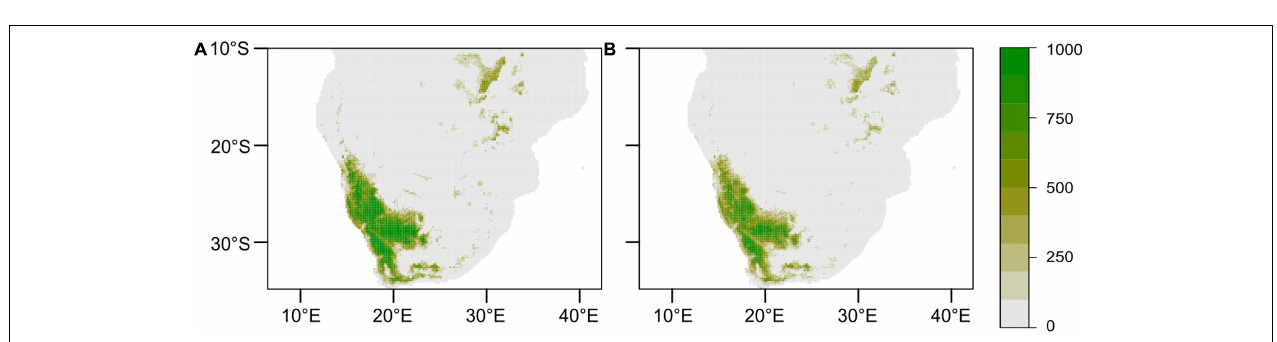
FIGURE 5 | Current modelled geographic range of Aloidendron dichotomum . Ensemble models of the generalised linear, generalised additive, and random forest models were computed using the (A) committee averaging and (B) weighted means methods. Colour scale indicates density